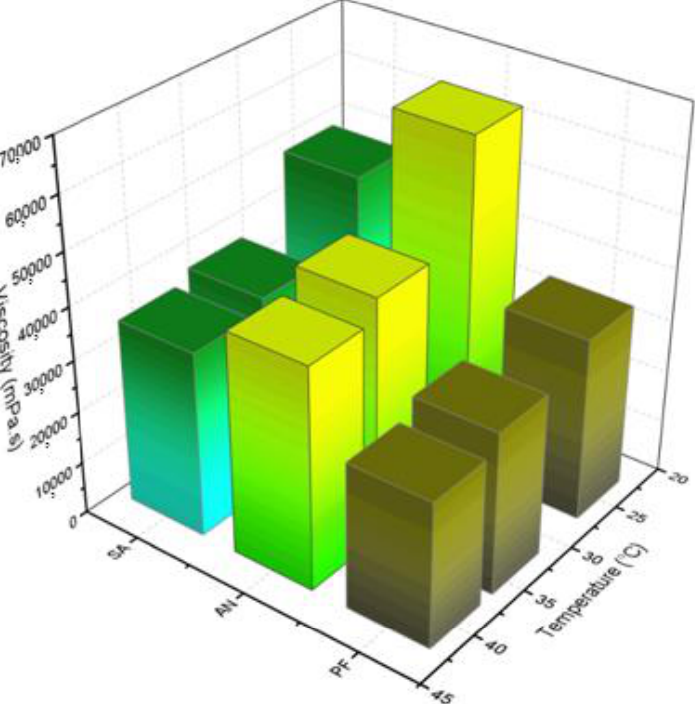
Figure 3. Viscosity (mPa.s) of sweet almond (SA), andiroba (AN) and passion fruit oils at 25, 34 and 40 °C. Each value represents the mean value of four replicates.